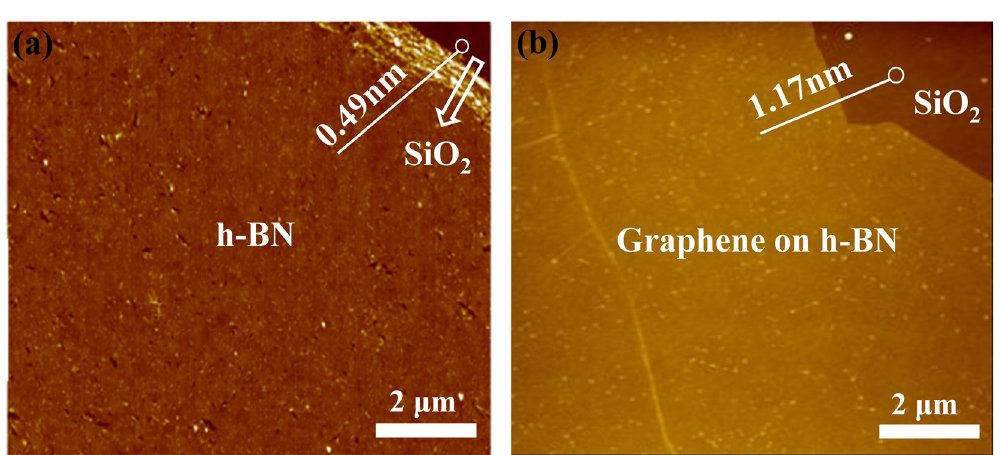
Figure 7. AFM images of samples. ( a ) Single-layer h-BN, and ( b ) graphene on h-BN transferred onto a 300-nm-thick SiO 2